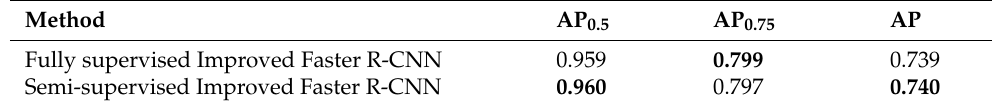
Table 9. Comparison with the fully supervised Improved Faster R-CNN. Method Fully supervised Improved Faster R-CNN Semi-supervised Improved Faster